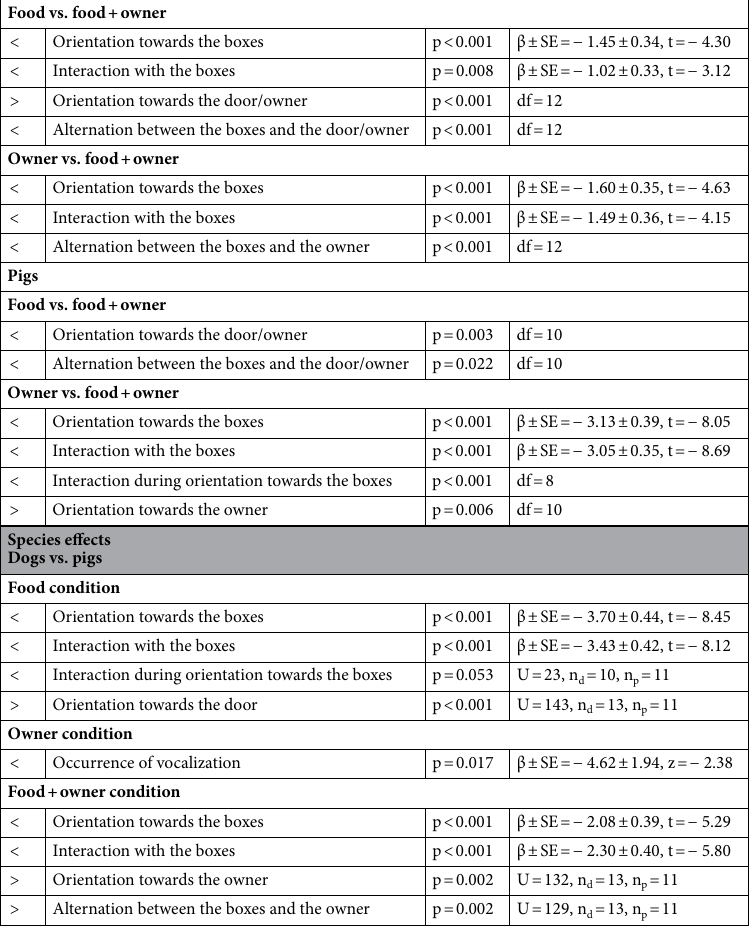
Table 1. Condition and species effects. Results of Durbin-Conover post hoc tests, Mann–Whitney U Tests and pairwise comparisons of Generalized Linear Mixed Models.